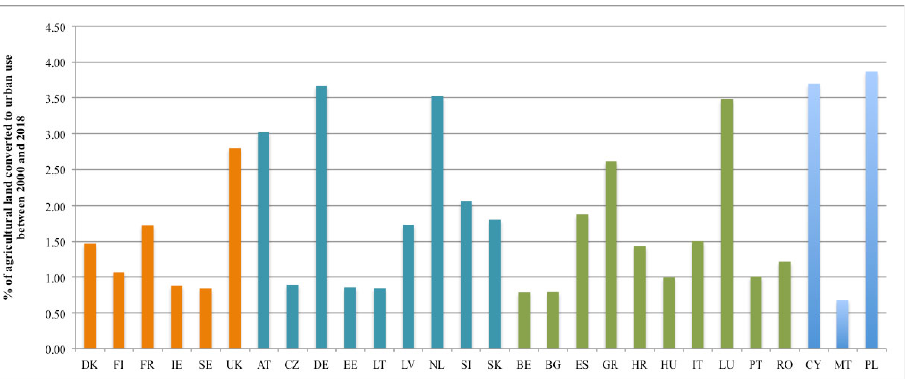
Figure 5. Percentages of agricultural land converted to urban uses in different planning systems. Note: The colours from left to right represent ‘state ‐ led’, ‘market ‐ led neo performative’, ‘conformative’ and ‘mis ‐ led performative’ systems. Source: Figure was created by the authors based on the CLC data obtained from EEA [24].